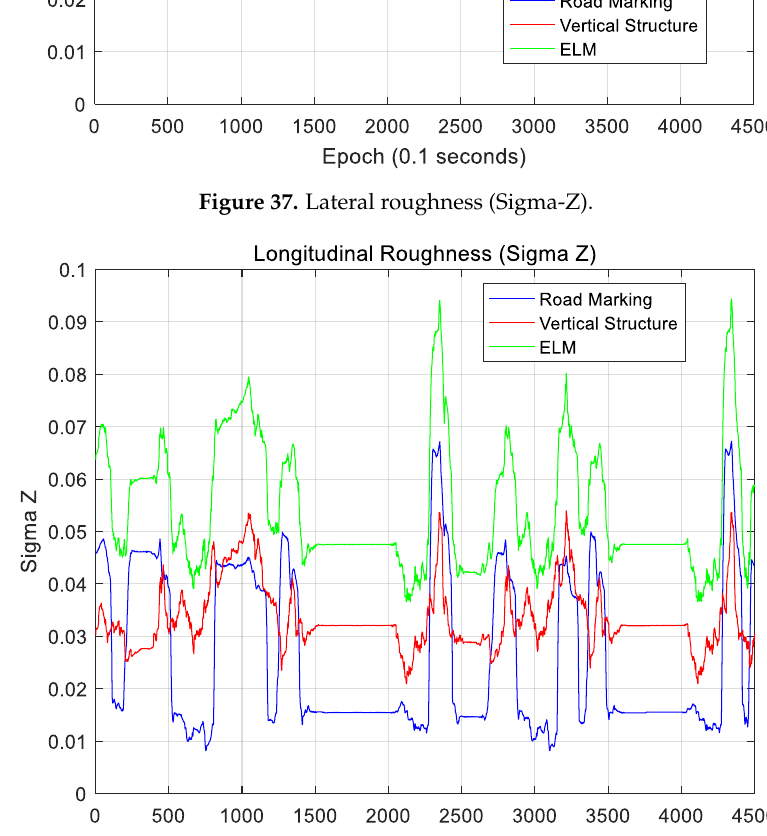
Figure 38. Longitudinal roughness (Sigma-Z).